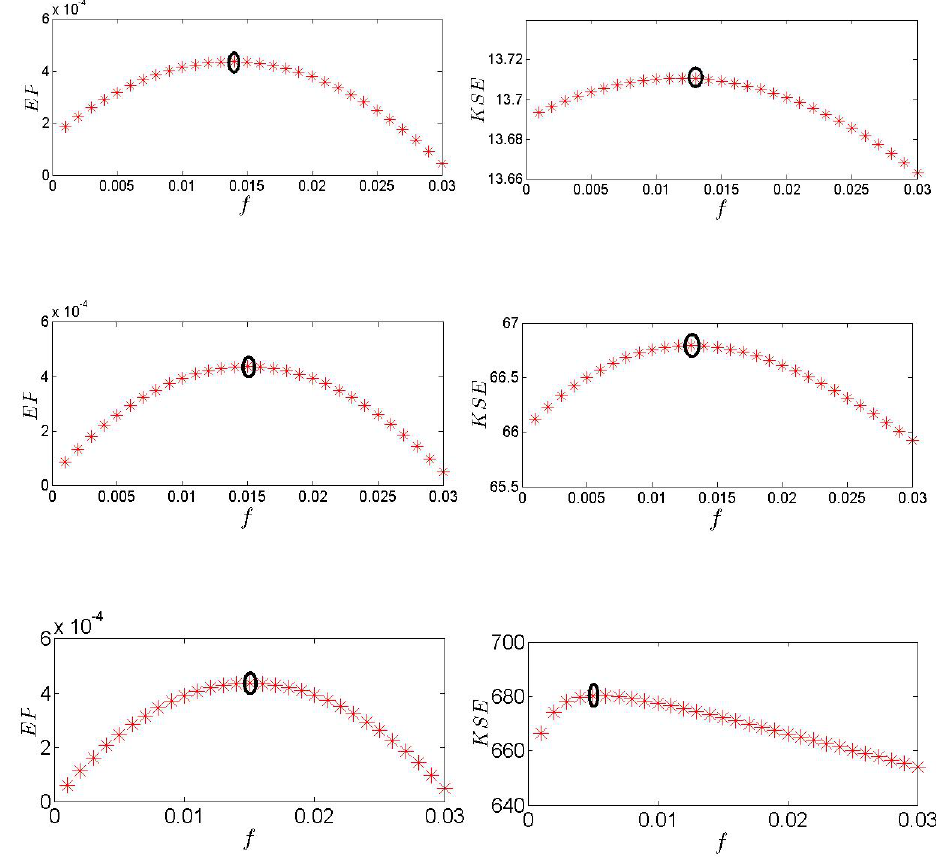
Figure 1. Entropy production calculated using Eq. (11) (left) and KS entropy calculated using Eqs. (7) and (15) (right) as functions of f for s = 0 . 13 and respectively N = 20, N = 100 and N =